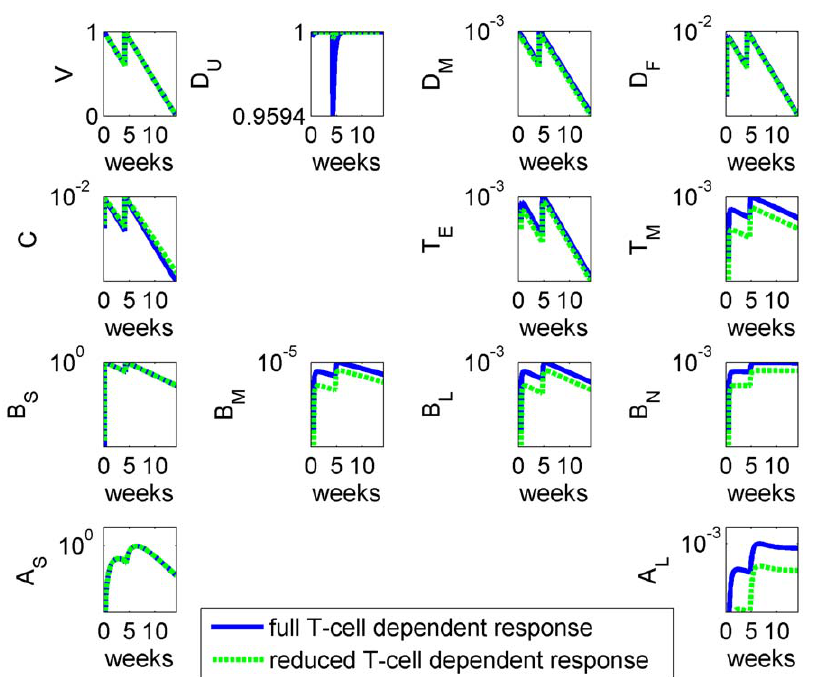
Figure 7. Model results for the full system (blue) and for the system with a reduced T-cell dependent response only (green), where and ª D have been reduced to 1% of their original values. All figures present variables on a log scale as percentages of their peak value. ª D U D M U D F